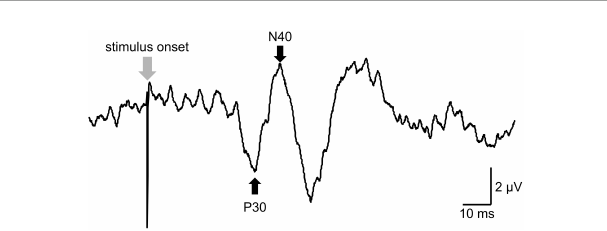
FIGURE2 The raw data of somatosensory evoked potentials (SEPs). The peaks of the SEPs were labeled based on latency from the stimulus onset for peak-to-peak analysis. P30 was defined as a positive peak with a latency of around 39 ms (39 ± 5 ms). N40 was defined as a negative peak following P30 and with a latency of around 45 ms (45 ± 5 ms).